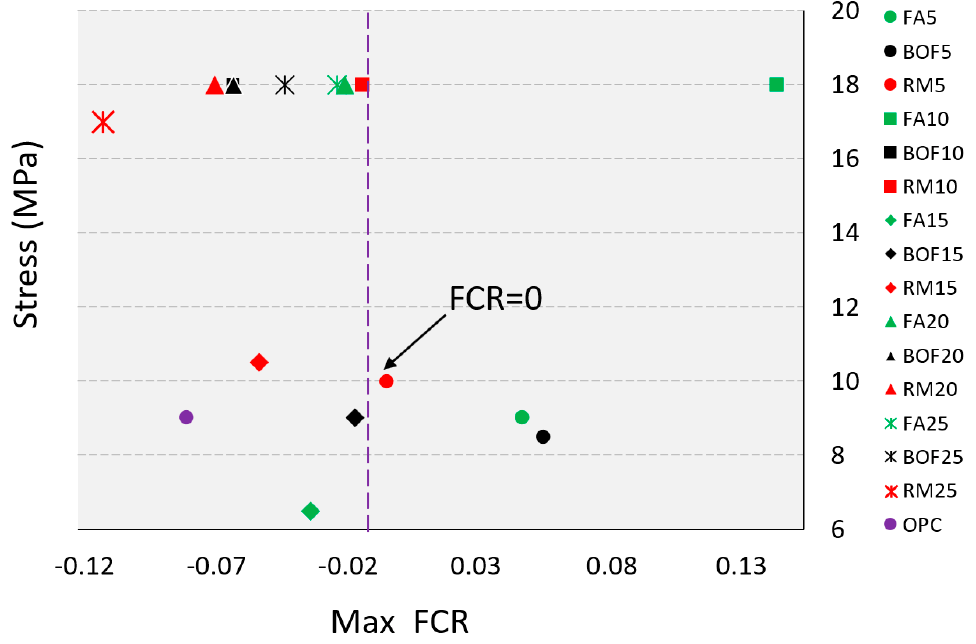
Figure 9. Maximum of fractional change of resistivity (FCR) during loading. Table 4. Stress sensitivity coefficient results for cement mortars at the age of 28 days.